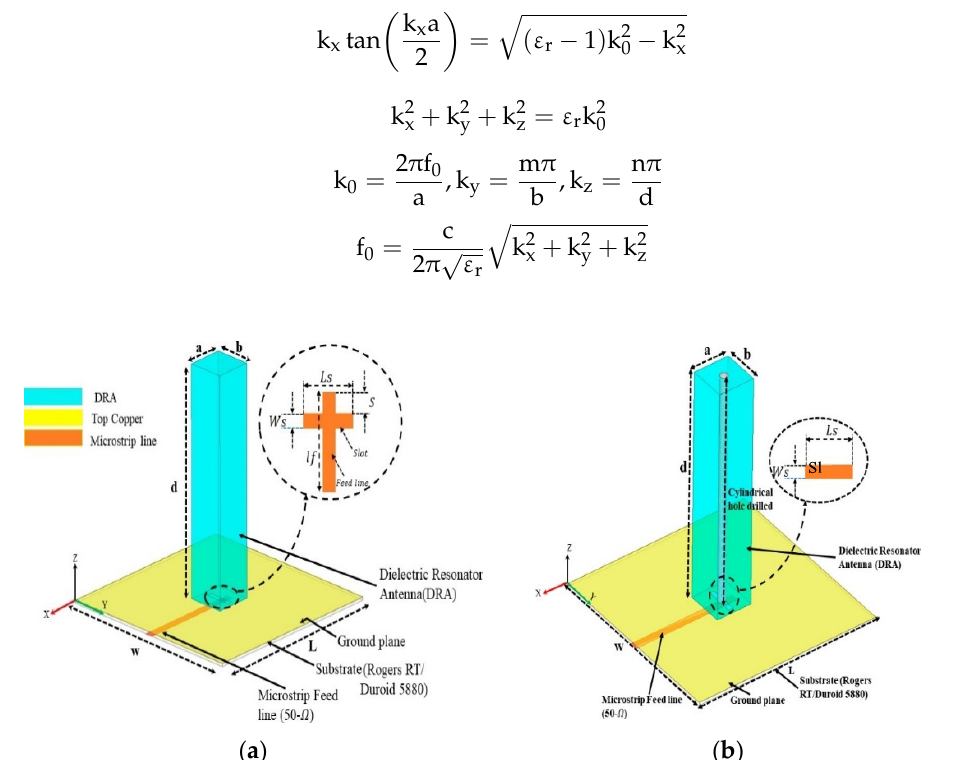
Figure 9. Configuration of (DRAs): ( a ) (DRA1) without hole TE δ 15 mode; ( b ) (DRA2) with cylindrical hole TE δ 15 mode [18].